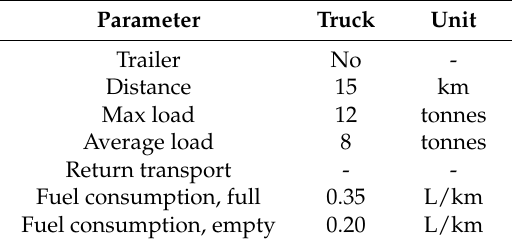
Table A2. Vehicle data for manure collection. Emissions of NO x and SO x complies with Euro 5.